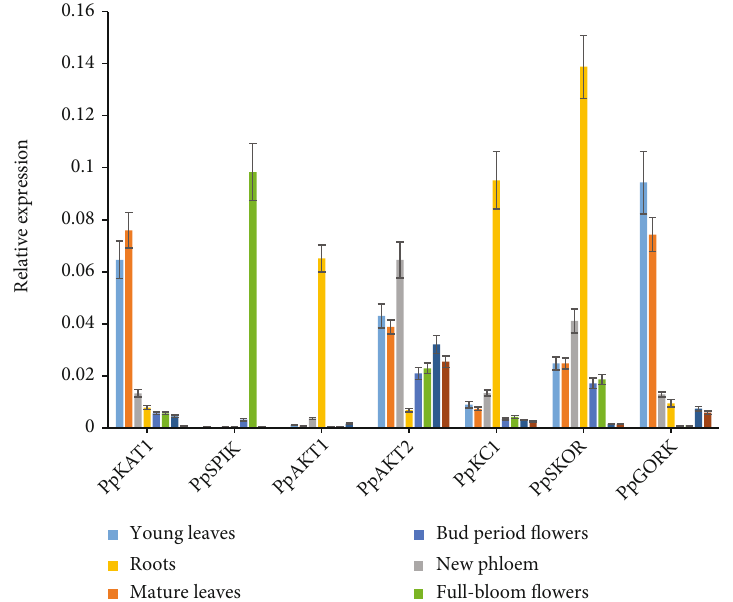
Figure 4: Tissue-/organ-speci fi c expression analysis of the peach shaker K + channel genes. Control ABA NaCl PEG